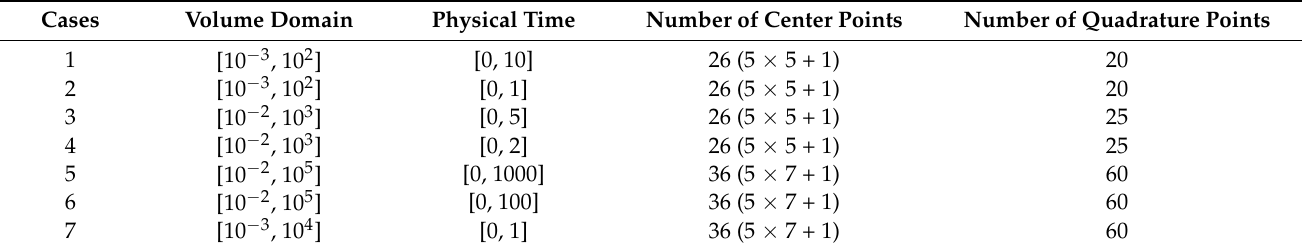
Table 2. Numerical settings of the RBF method for different cases.